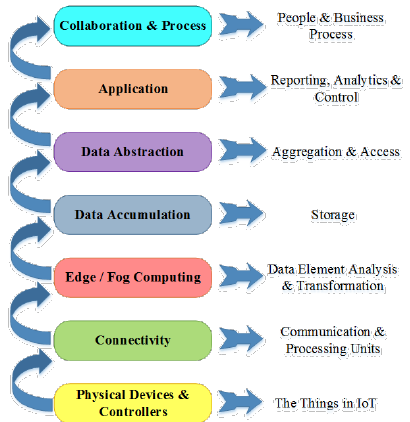
Figure 12. IWF 7-layered reference